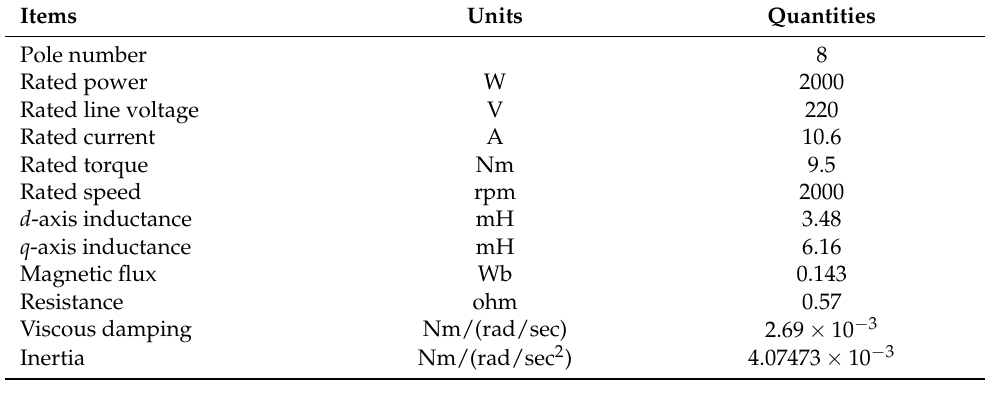
Table 2. Parameters of IPMSM.